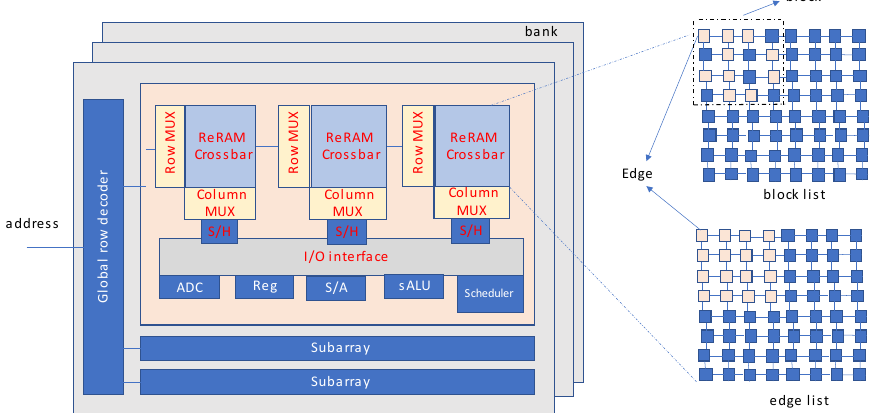
Figure 20. GraphSAR architecture with allocation of data with respect to the block and edge lists [23].